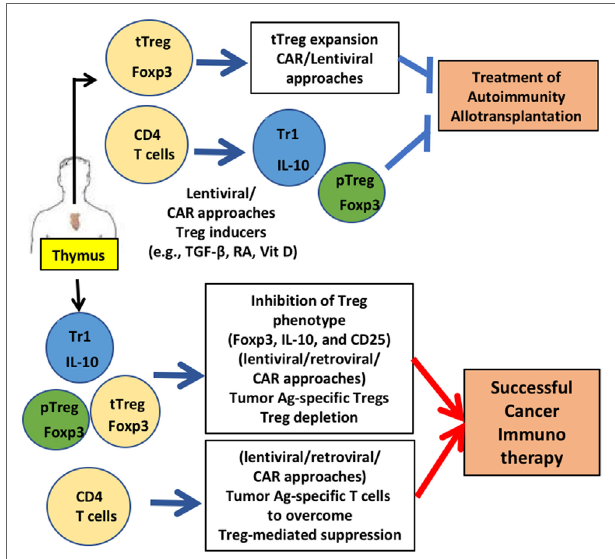
FiGURe 1 | Gene-modified regulatory T cell (Treg)-mediated therapy. Engineering of Tregs aims to generate Tregs that are functionally similar to various types of Tregs that were identified in human: thymic-derived thymic-derived Treg (tTreg), transforming growth factor (TGF)- β -induced peripheral Treg (pTreg), and IL-10 expressing Tr1 cells. CD4 T cells and Tregs are generated from thymus. For treating autoimmunity or allotransplantation, gene-modification approaches aim to acquire a stable Treg phenotype and sufficient numbers via in vitro expansion to obtain enough cells for treatment. Generation of antigen-specific Tregs reduces the number of Tregs for therapy significantly. For successful cancer immunotherapy, Treg function needs to be downregulated. Destabilizing Treg functions by inhibiting FOXP3 and other functional Treg proteins (e.g., CD25) by gene modification is under development. Applications for these gene-modified Tregs are currently being expanded in mice (e.g., humanized mice) and men (human Tregs for clinical